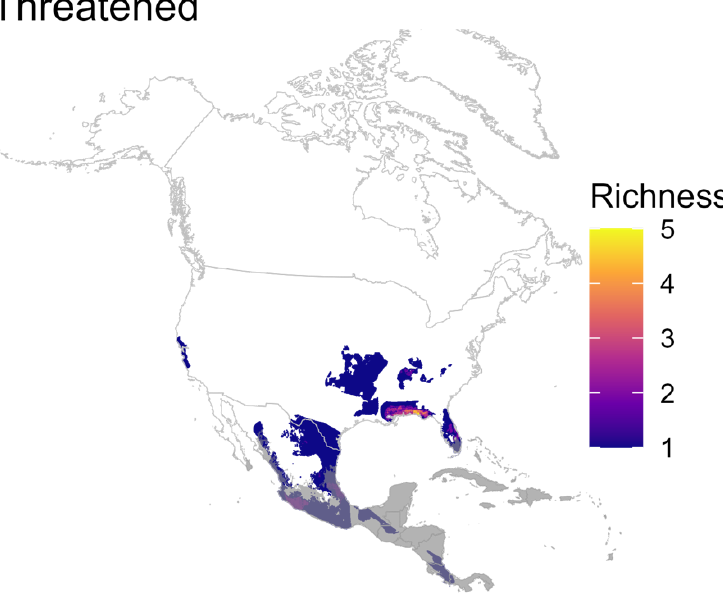
Figure 7. Distribution of the species richness for the IUCN Red List category of least concern.